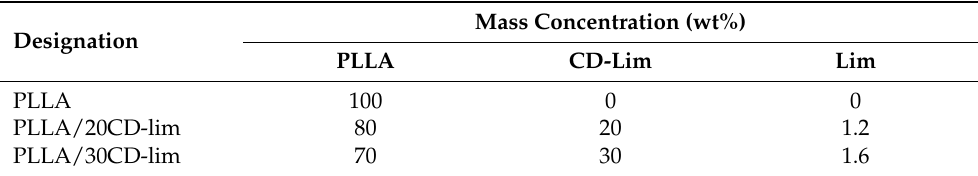
Table 1. Symbols and mass concentrations of